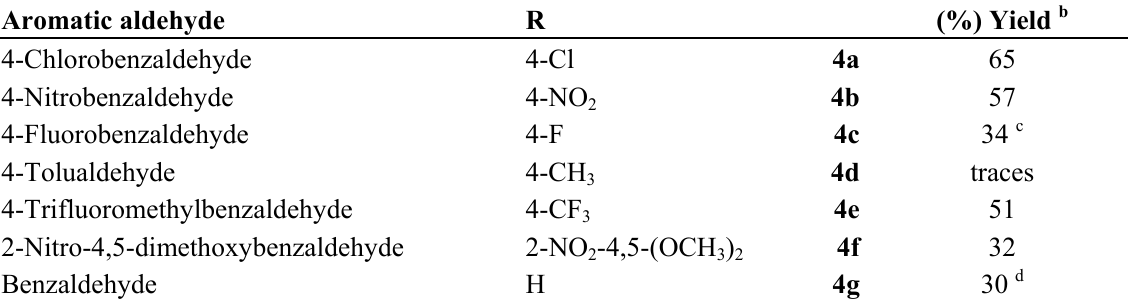
Table 2. Reaction of chloride 1 with various aromatic aldehydes a